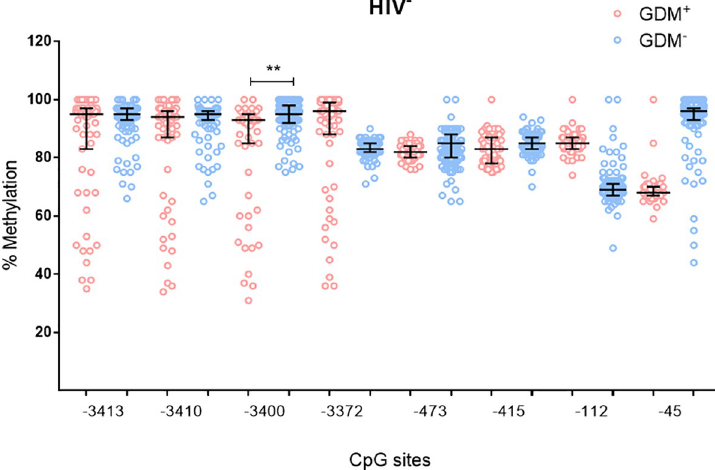
Fig 3. ADIPOQ promoter DNA methylation and GDM status in HIV - women. DNA methylation at eight CpGs within the promoter of ADIPOQ was measured in HIV - pregnant women with and without GDM (n = 118 GDM - ; n = 63 GDM + ). Data are represented in a scatter dot plot as the median and interquartile range. �� p < 0.01.